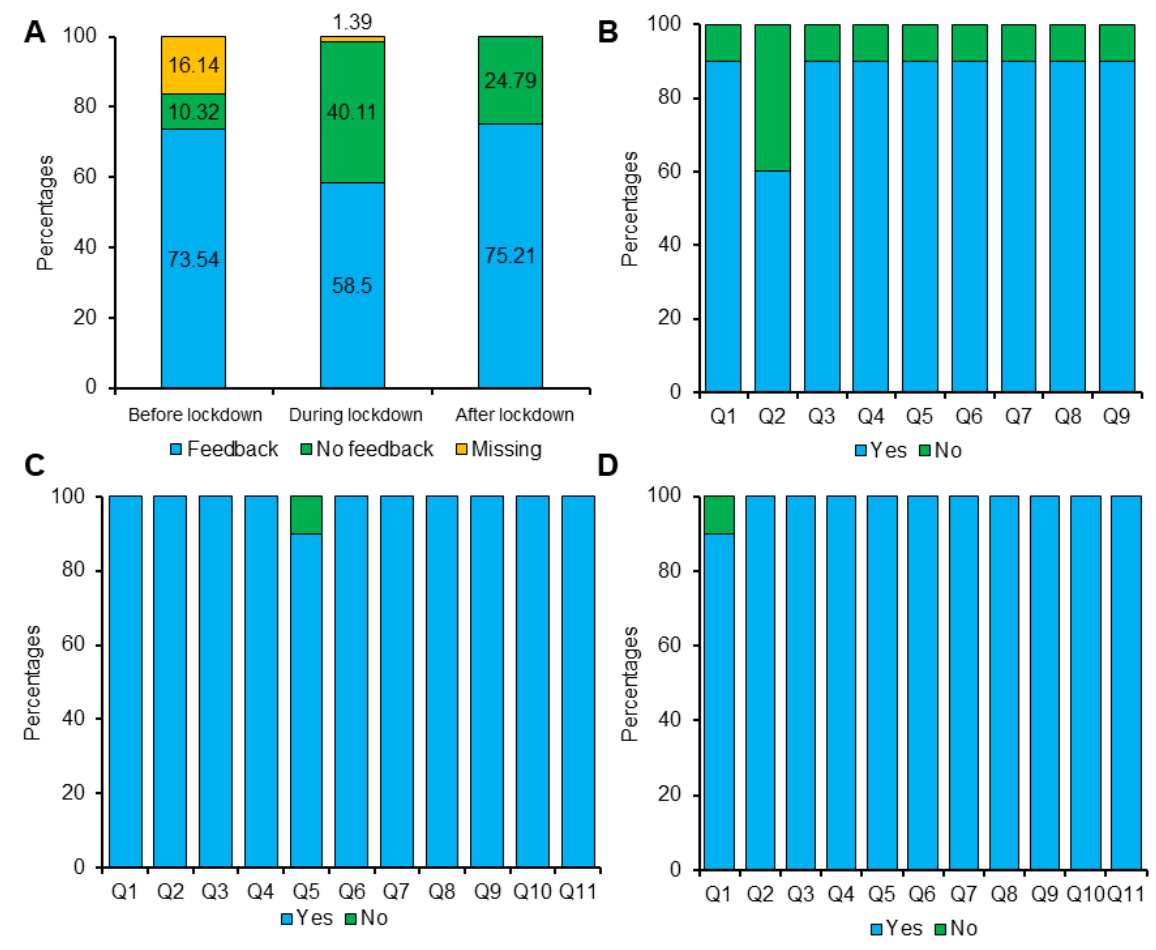
Figure 6. Feedback from the patient: ( A ) available and missing feedback; ( B – D ) the percentages of patient feedback before ( B ), during ( C ), and after ( D ) the lockdown, respectively.